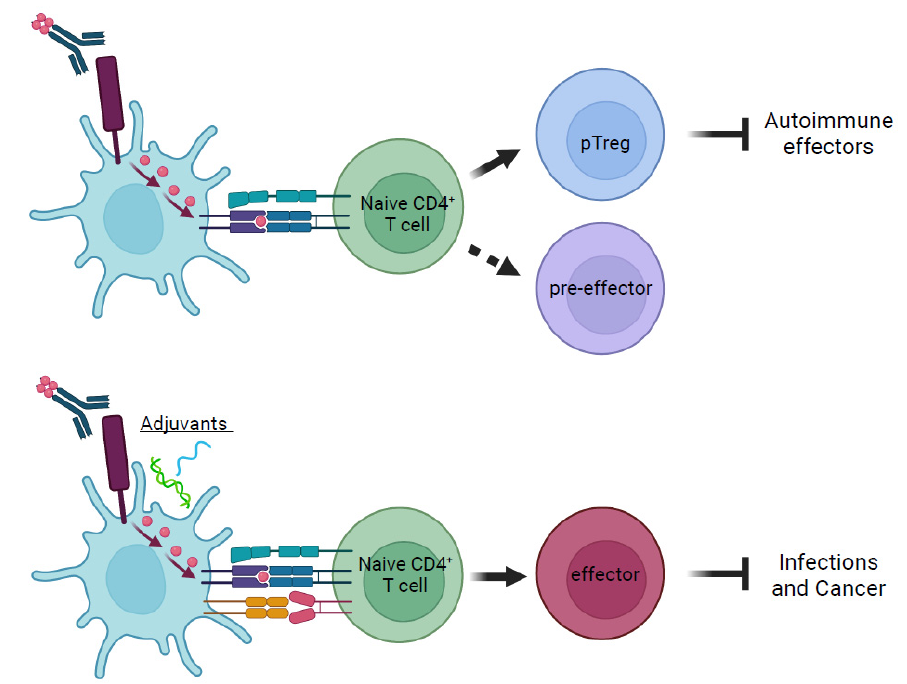
Figure 2. T cell outcomes of targeted antigen delivery to DC in the absence and presence of pro ‐ inflammatory signals.